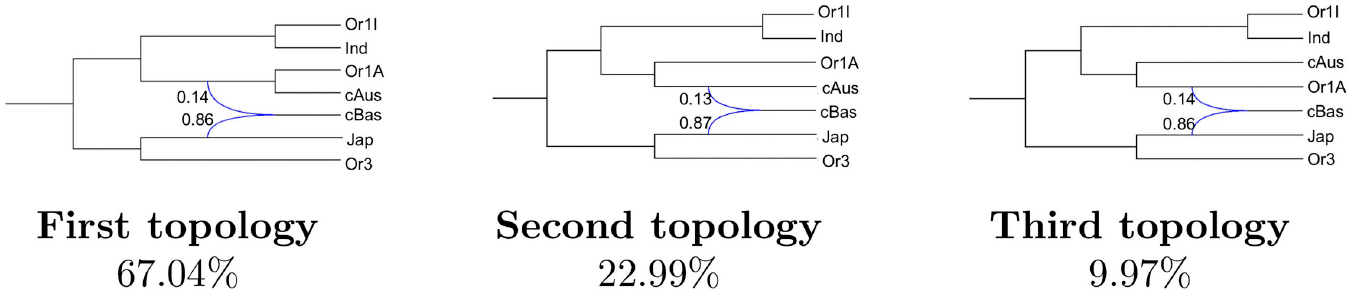
Fig 18. The three topologies sampled by S NAPP N ET when data set 3 was considered. Reported inheritance probabilities for each topology are averages on sampled observations.